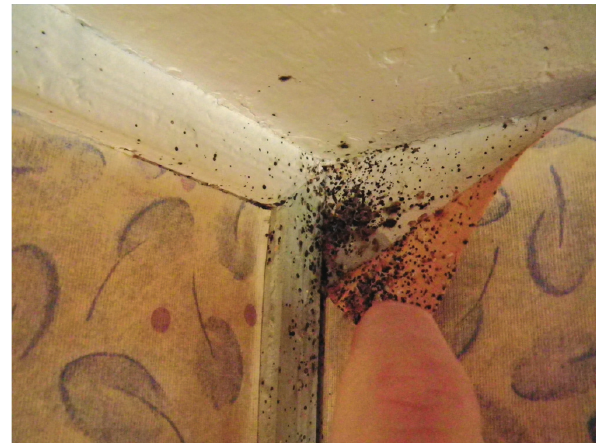
Fig. 1. – Adult bed bugs and excreta in a flat.